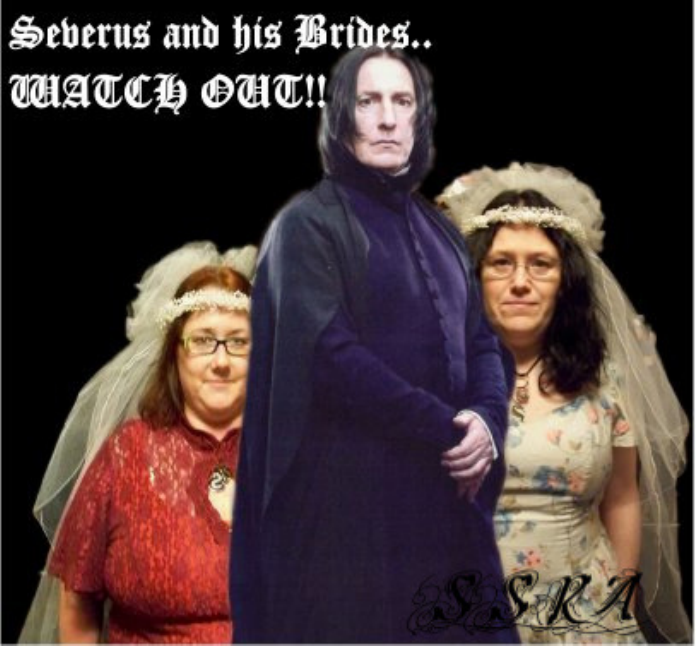
Figure 1. Snape as pictured with Rose (left) and Tonya (right). Photomanipulation made by